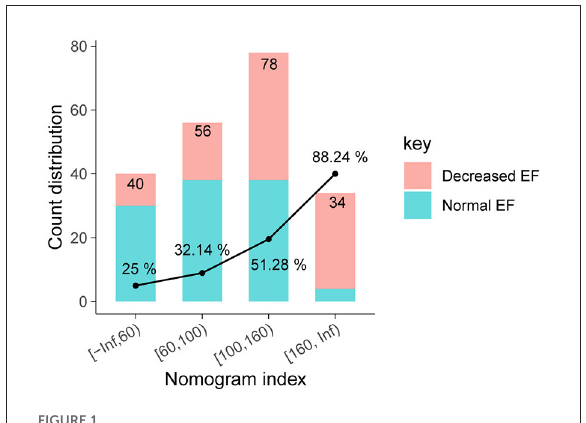
FIGURE1 Supervised tree-like segmentation of